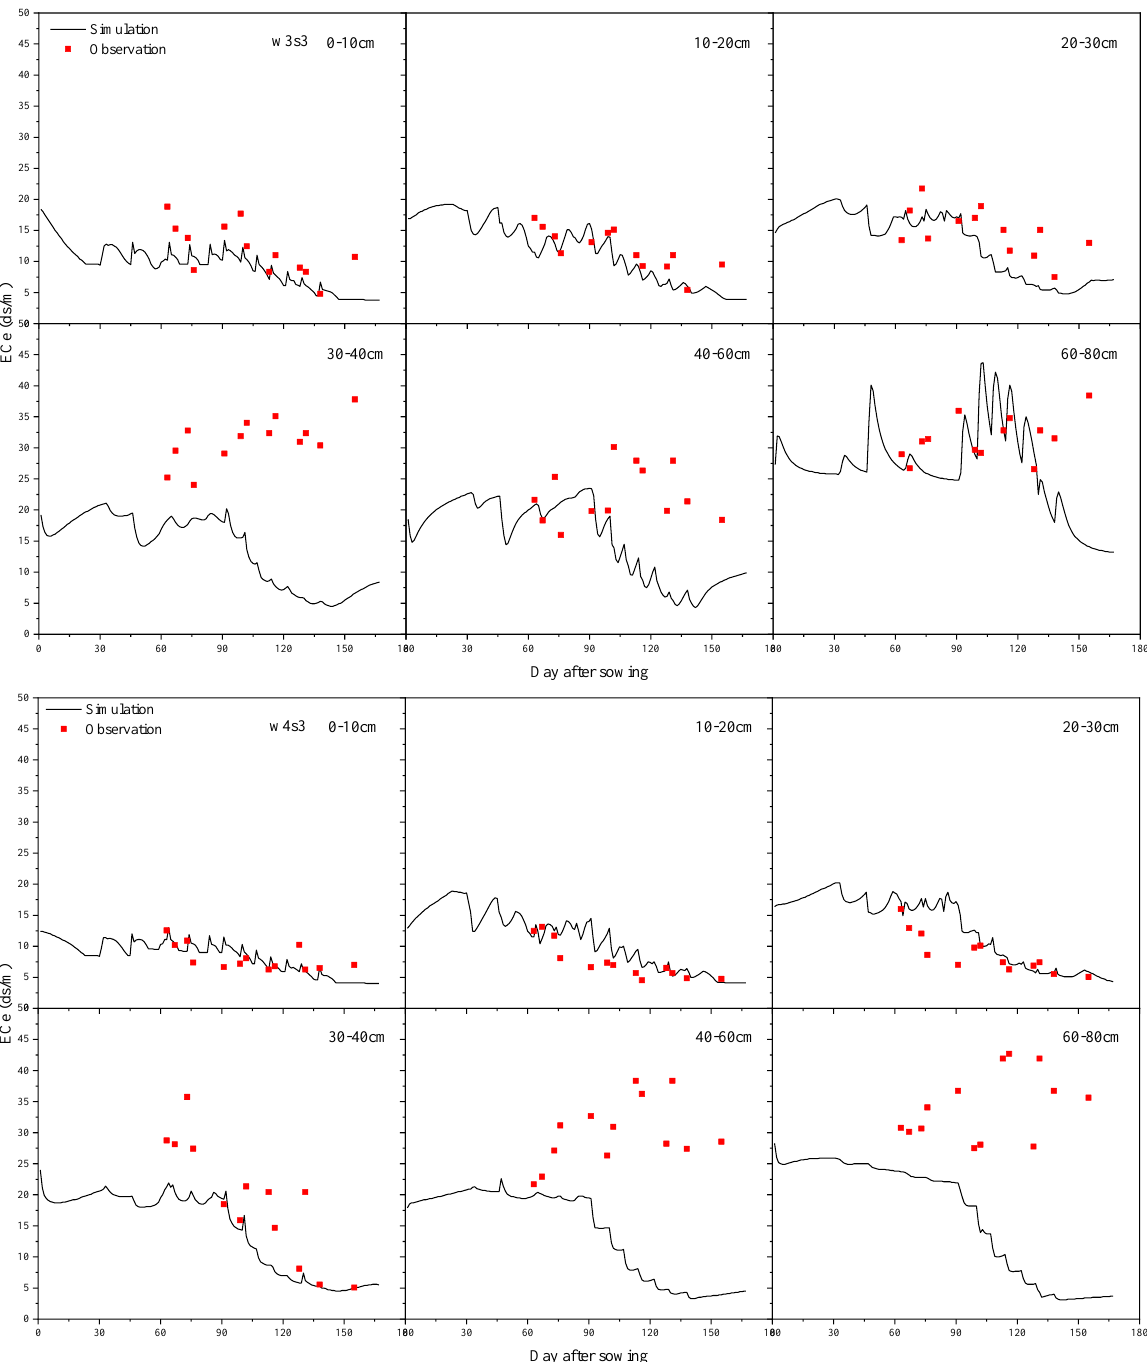
Figure 10. Comparison between observed and simulated average ECe in the 0 – 80 cm soil profile for different irrigation and salinity treatments (a-j). (The dots represent the measured data, the lines represent the simulated values. W1, W2, W3 and W4 represent irrigation amount of 22.5, 30, 37.5 and 45 mm. S1, S2 and S3 represent the soil salinity of 0.2%, 0.4% and 0.6%.)